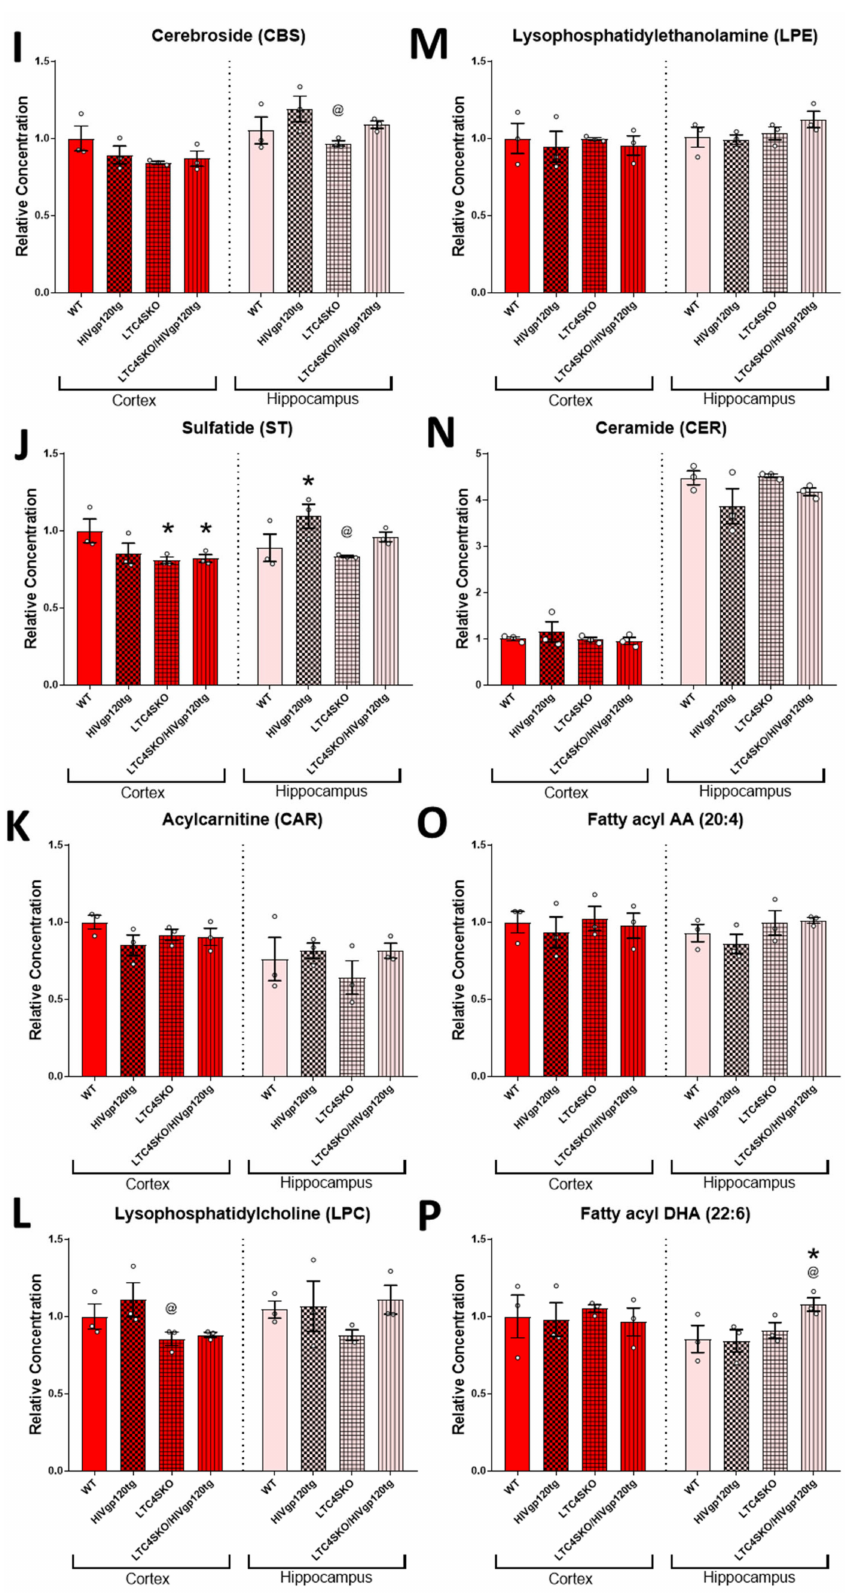
Figure 4. (Previous two pages) Total lipid class populations in cortex and hippocampal tissue extracts show that HIVgp120tg- and LTC4SKO-induced alterations have differential and regional effects. Individual analytes of lipid classes measured through multi-dimensional mass spectrometry-based shotgun lipidomics (MDMS-SL) were summed to equate the representative population for each